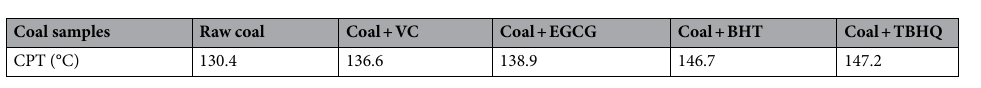
Table 3. The CPT of raw coal and the antioxidant coal sample.